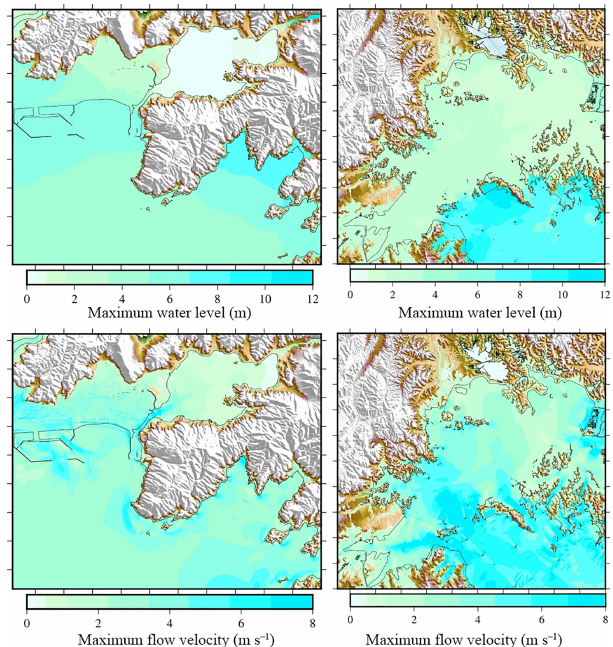
Figure 5. Simulated maximum water level and flow velocity in Mangokuura Lake and Matsushima Bay.